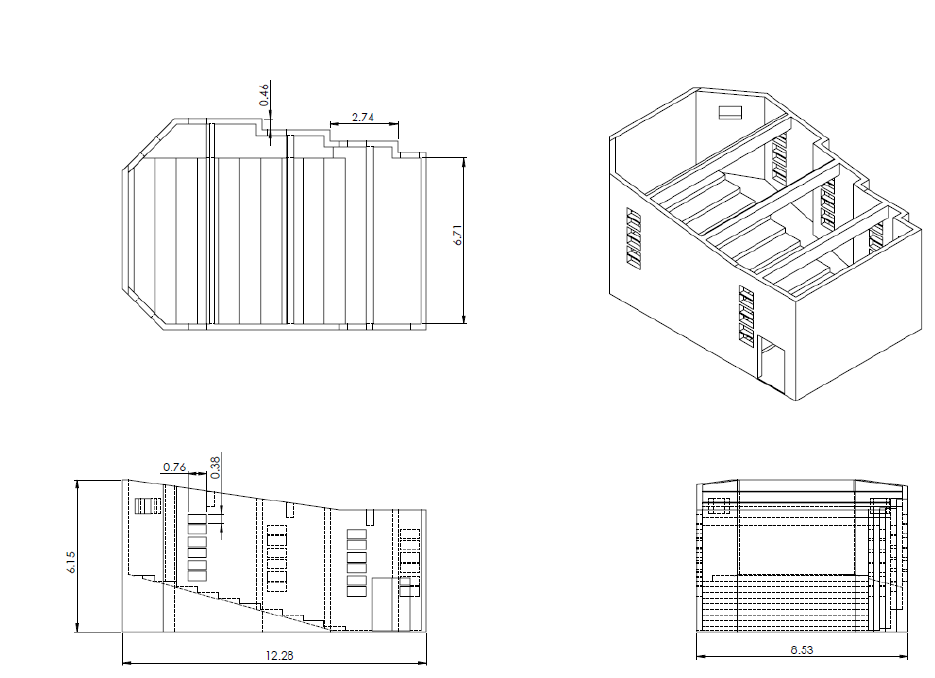
Figure 5. Major dimensions of geometry